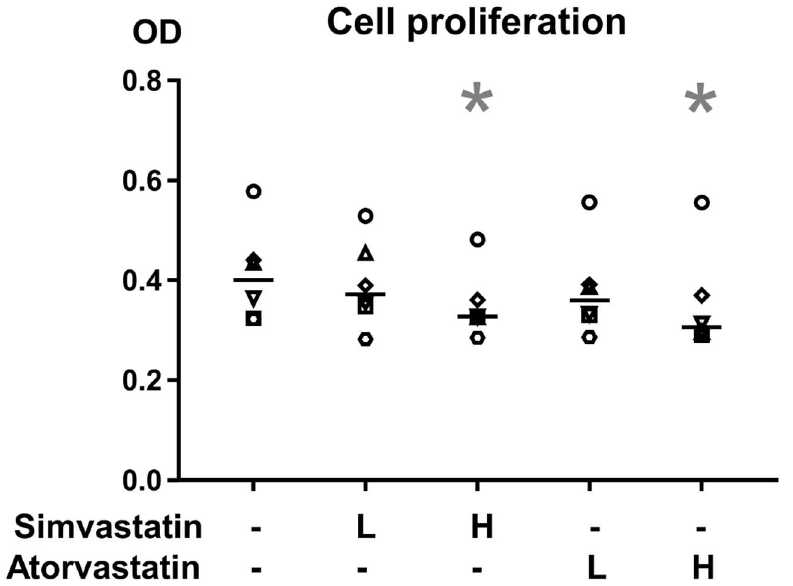
Fig 4. Cell proliferation. Cell proliferation in tendon constructs, with or without statin treatment for 7 days, measuredby a MTT assay. The data is presentedas opticaldensity (OD) value. Low dose (L) statin treatment corresponds to 0.05 μ M(simvastatin or atorvastatin) and high dose (H) corresponds to 0.5 μ M. The line represents median value. Individual donor-specificcell lines are representedby the six different symbols. The cell proliferation was reducedin constructs treated with high dose simvastatin or highdose atorvastatin. Significant changesfrom DMSO-control are indicatedby * (p < 0.05).